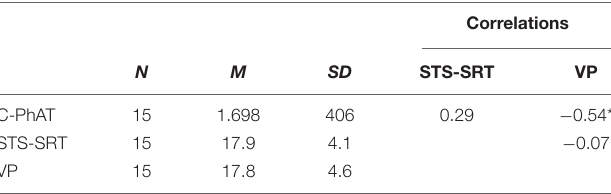
TABLE 1 | Descriptive statistics (means and standard deviations) on behavioral measures and their Pearson r